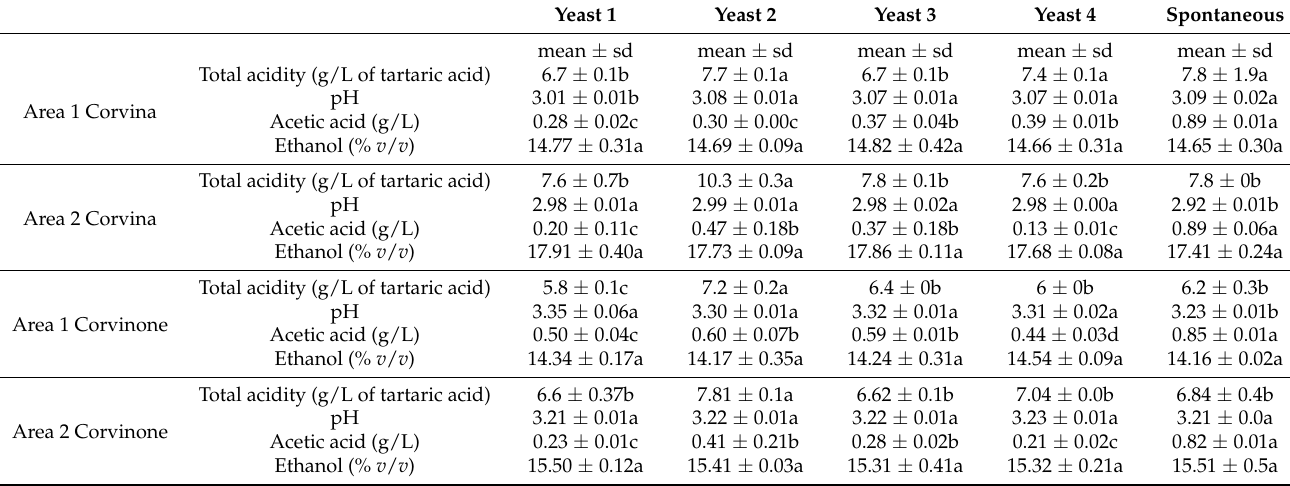
Table 2. Enological parameters of wines at the end of alcoholic fermentation (glucose and fructose <2